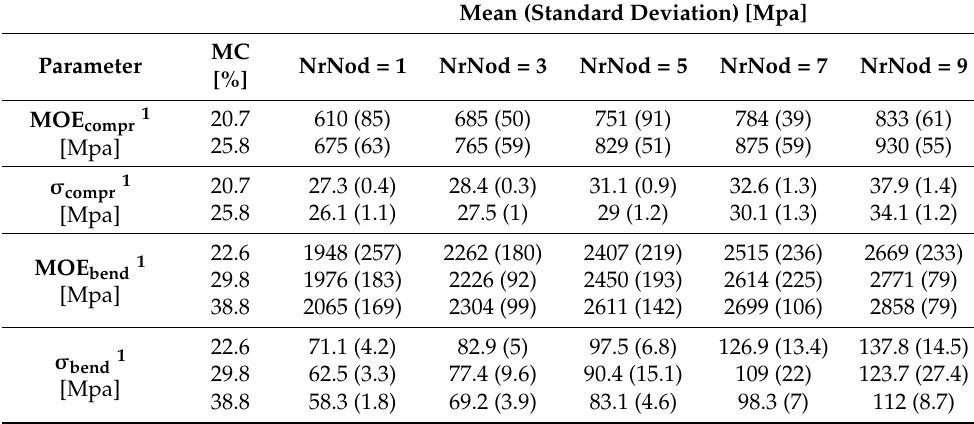
Table 4. Values of strength parameters of miscanthus stalk (MOE compr , σ compr , MOE bend , σ bend ) obtained in the compression tests along the fibers and three-point bending test. The mean and standard deviation (SD) values are included. Mean (Standard Deviation) [Mpa] MC NrNod = 1 Parameter [%]